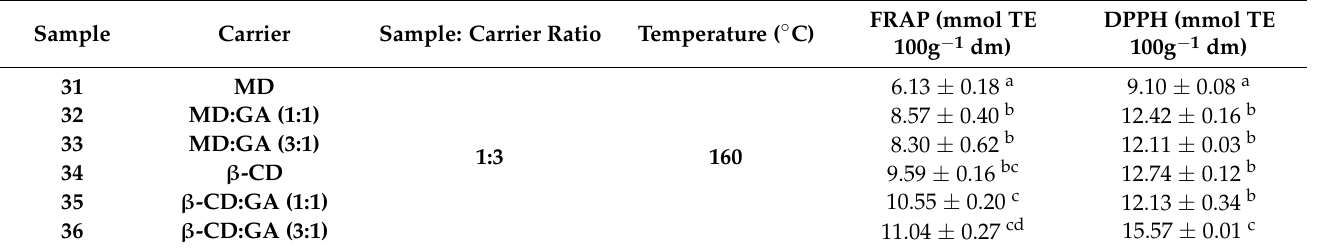
Table 3. Antioxidant capacity of nettle leaf powder obtained at same conditions (160 °C and sam- ple:carrier ratio 1:3) with different carriers.